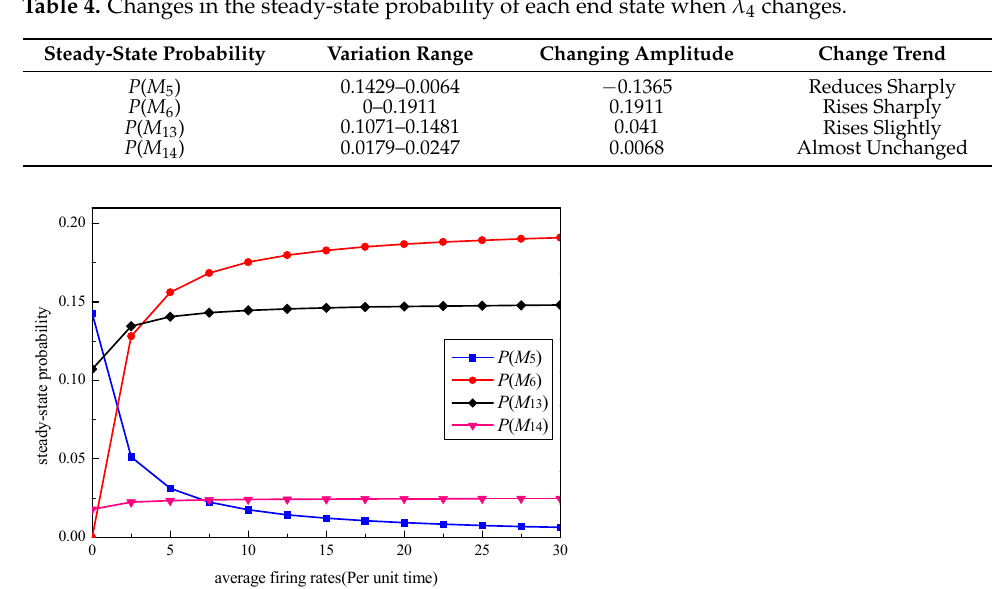
Figure 7. Simulation results of each steady-state probability when λ 4 changes.